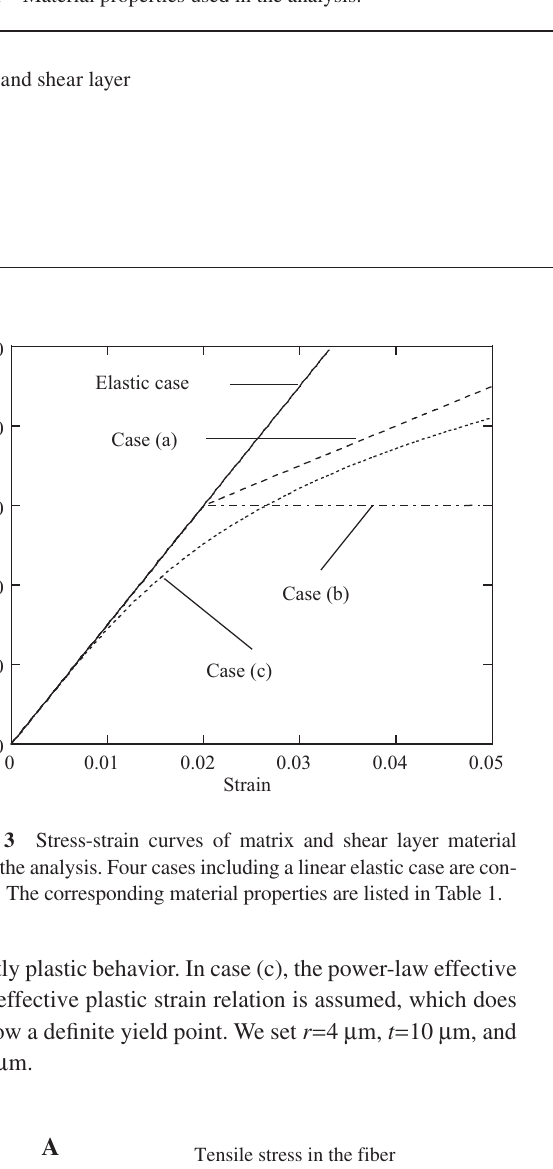
Table 1 Material properties used in the analysis.